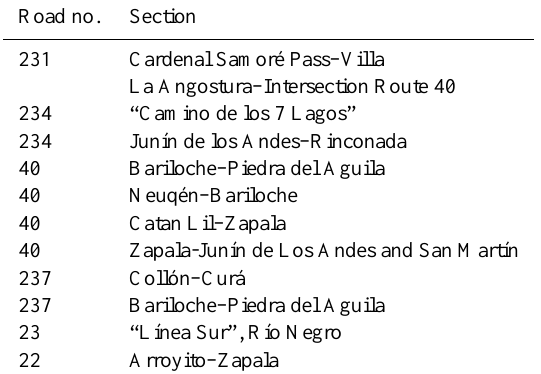
Table 4. List of the routes in Neuquén and Río Negro provinces closed during CC eruption (see also Fig.